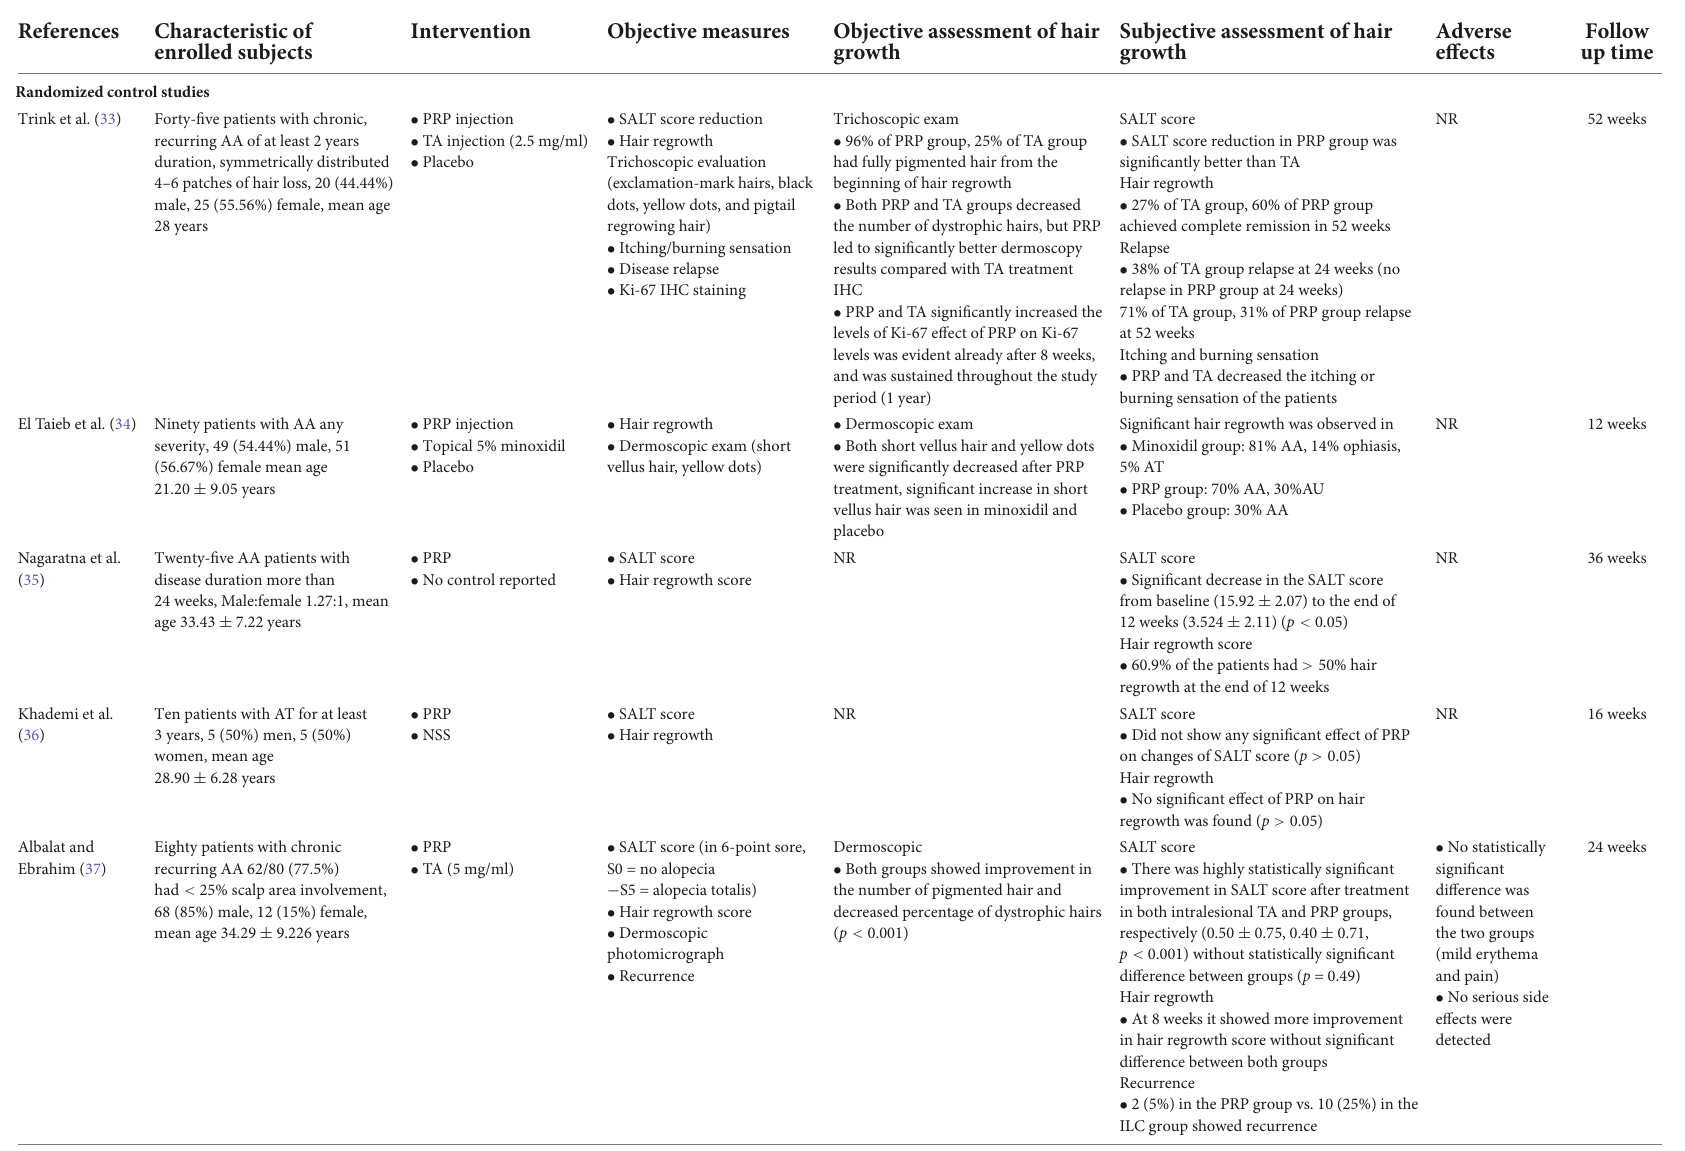
TABLE 1 Characteristics of alopecia areata studies included in the systematic